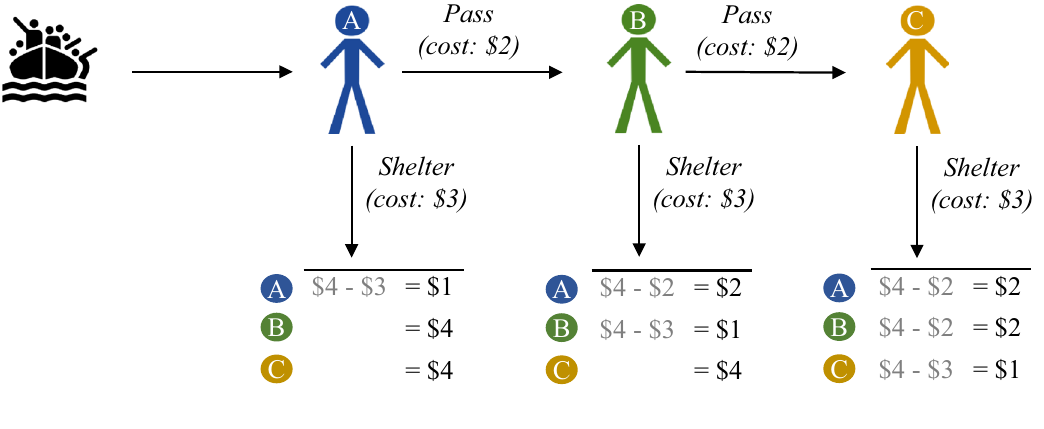
Figure 1. The pass-the-buck game (one-way